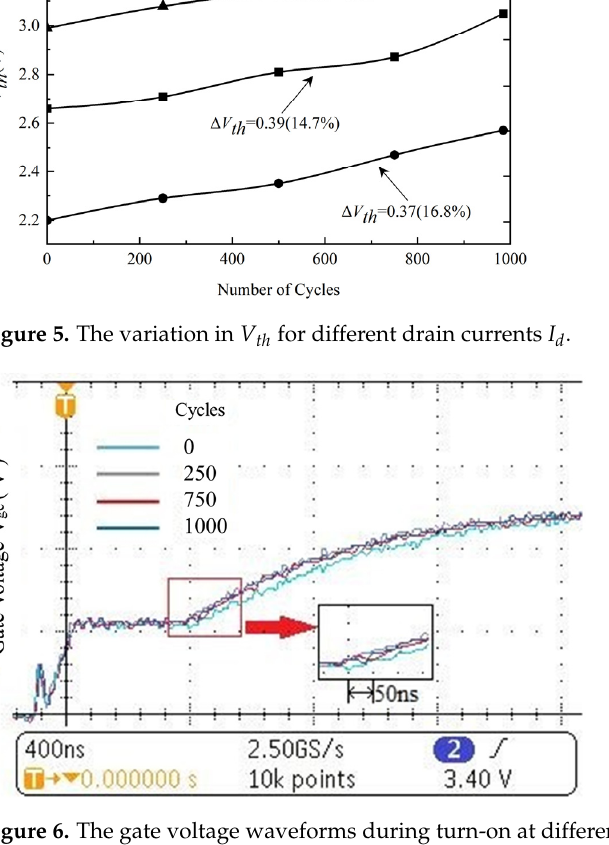
Figure 6. The gate voltage waveforms during turn-on at different numbers of power cycles.